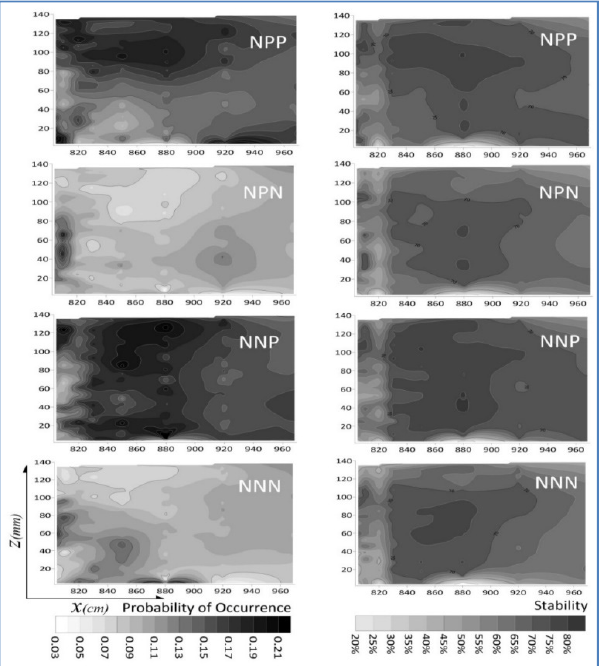
Figure 6. Probability of the occurrence and stability of octant classes NPP, NPN, NNP and NPP behind the vegetation patch.